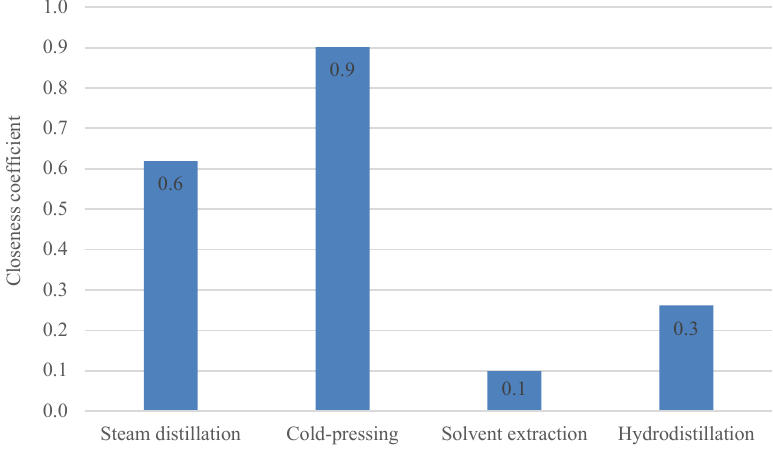
Fig. 3. TOPSIS ranking technologies